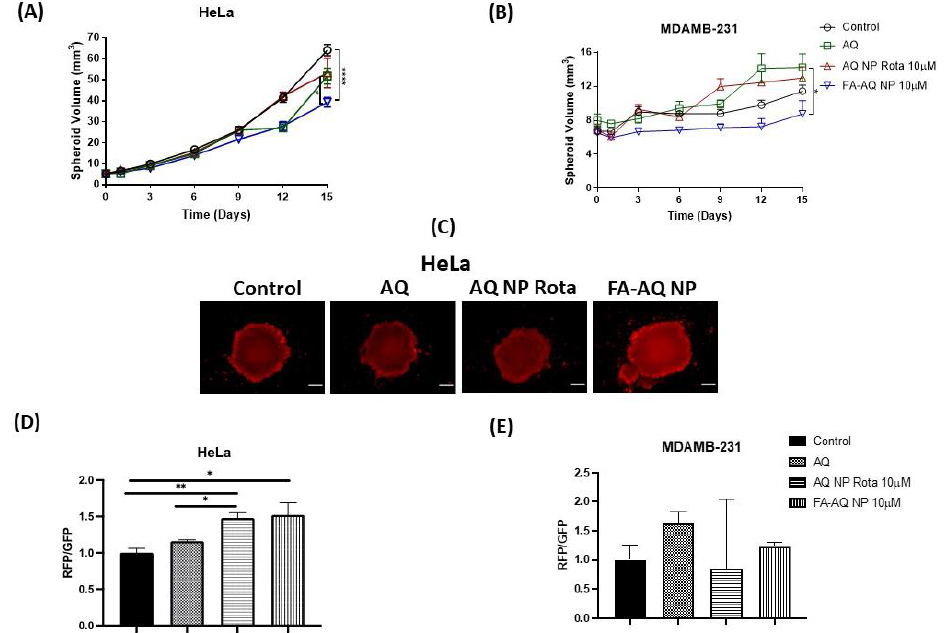
Figure 9. Three-dimensional spheroid study: Spheroid volume comparison plots for HeLa ( A ) and MDAMB-231 ( B ) spheroids. Data represent mean ± SEM (n = 8). * p < 0.05 and **** p < 0.0001. ( C ) Live-dead cell assay: Red fluorescence intensity demonstrated by HeLa spheroids. Images were captured using Evos-FL fluorescence microscope with 4 × objective. ( D ) The graph represents comparison of red fluorescence intensity/green fluorescence intensity of HeLa spheroids. ( E ) The graph represents comparison of red fluorescence intensity/green fluorescence intensity of MDAMB-231 spheroids Data represent mean ± SEM (n = 4). * p < 0.05, ** p < 0.01.